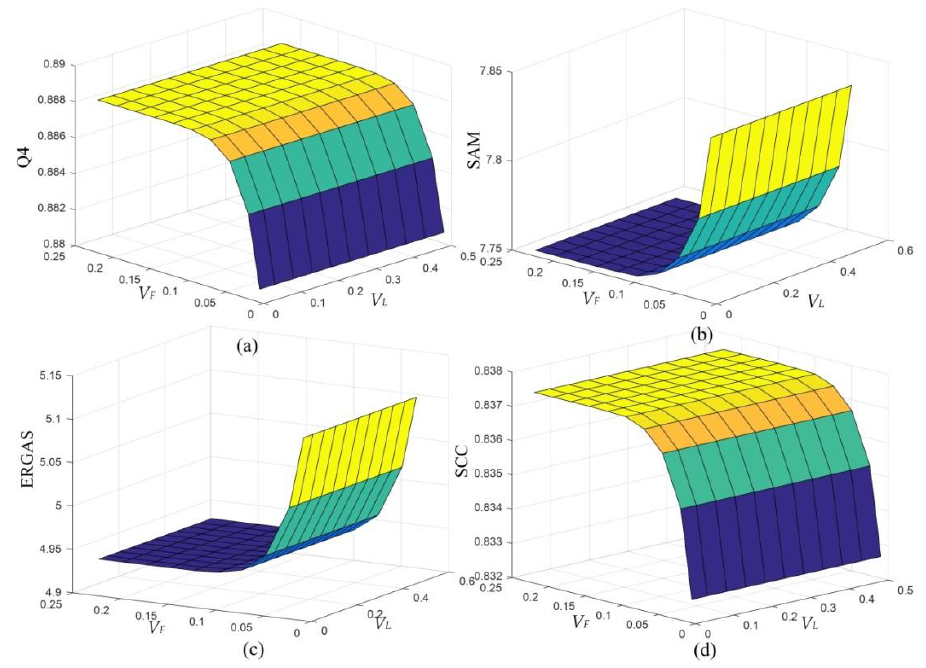
Figure 8. Analysis of the parameters V F and V L . ( a ) Q4. ( b ) SAM. ( c ) ERGAS. ( d ) SCC.